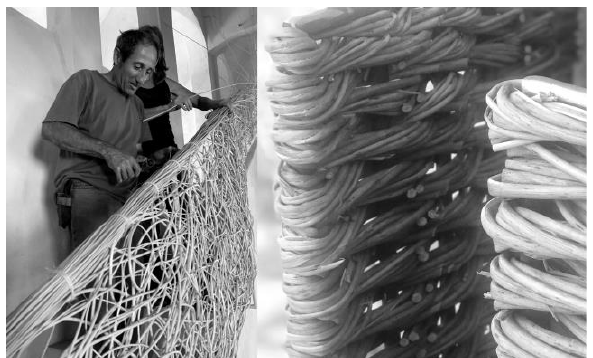
Figure 7. We have stimulate from the design the return